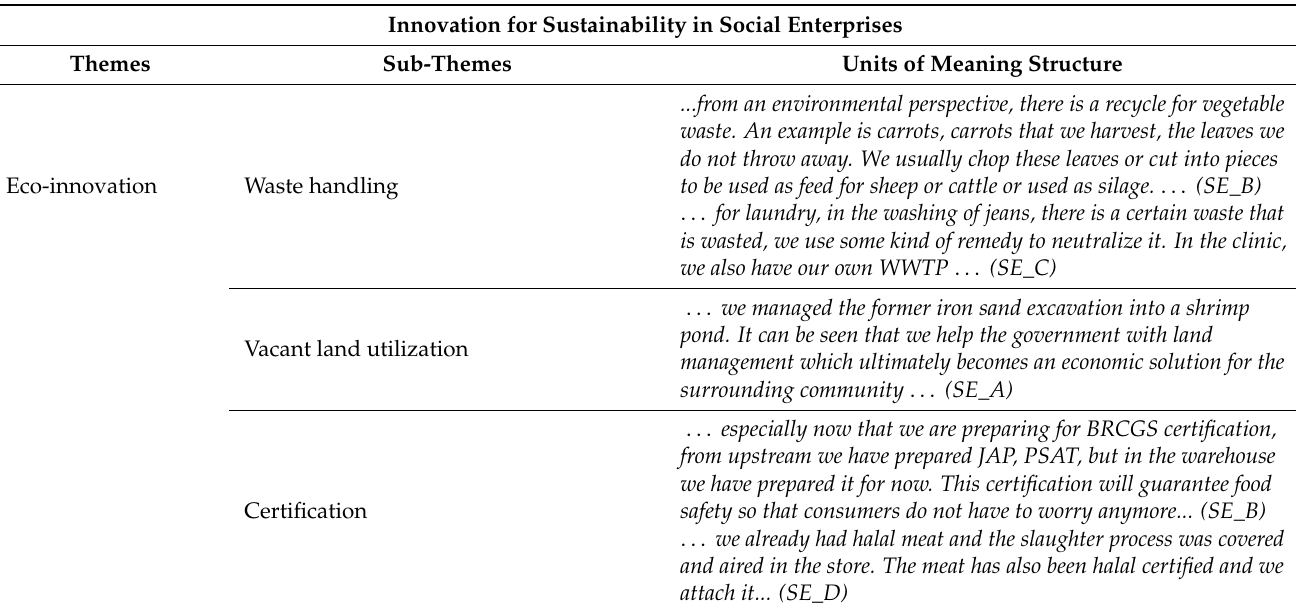
Table 1. Data structure units of meaning innovation for sustainability in social